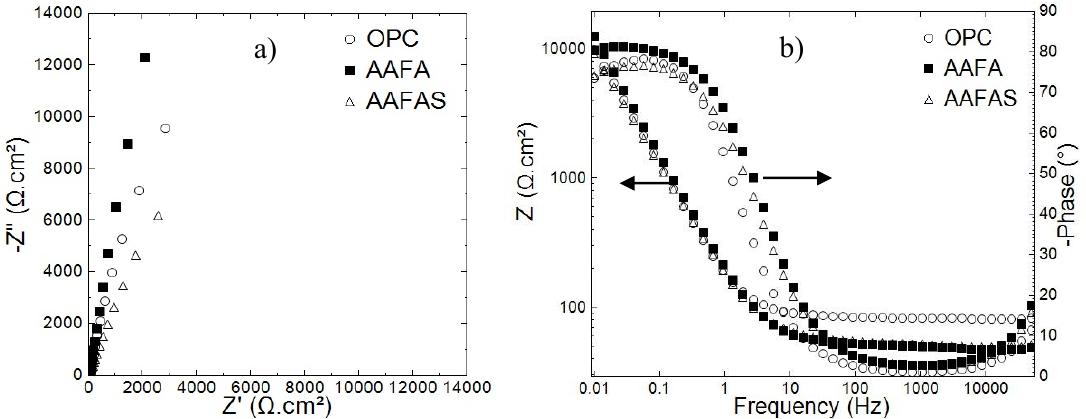
Figure 10. Nyquist ( a ) and Bode ( b ) diagrams of embedded steels in OPC, AAFA, and AAFAS mortars exposed for 4 days at the end exposure conditions.